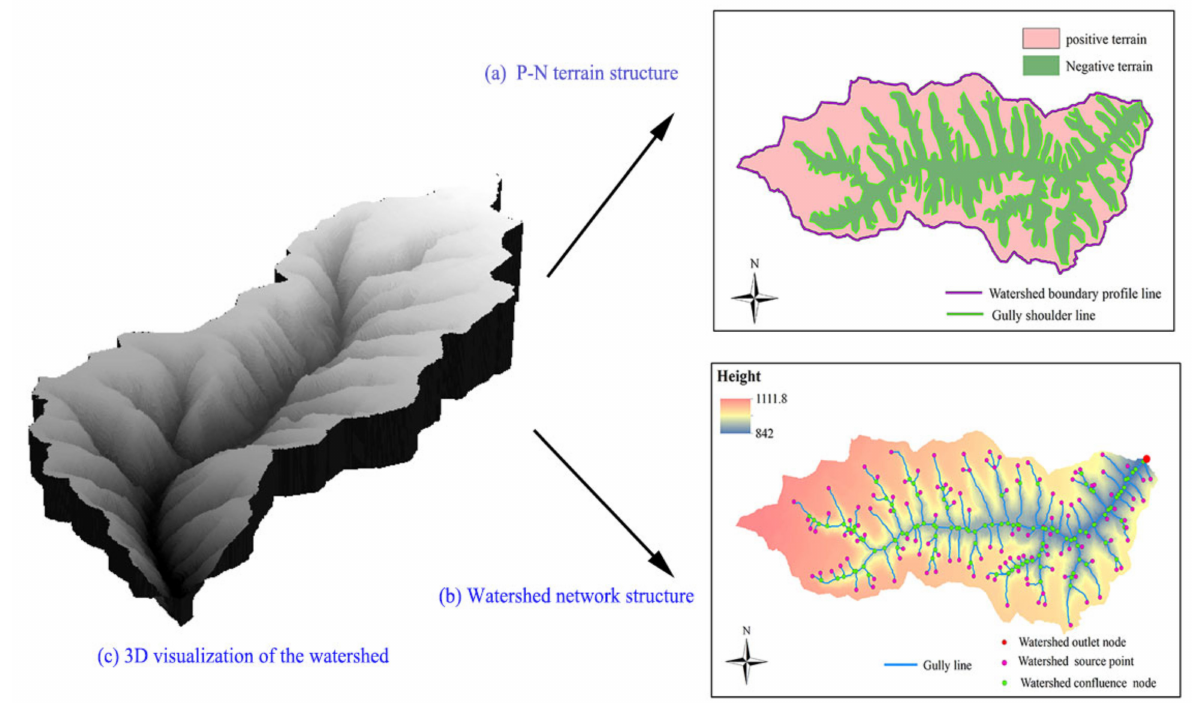
Figure 2. Two kinds of spatial structures for the watershed. ( a ) is the P–N terrain structure. The watershed spatial structure can be divided by the watershed boundary profile line and gully shoulder line into positive terrain and negative terrain. On the other hand, the watershed is a complete gully spatial structure, as shown in ( b ). From the perspective of the complex network, the watershed can be also abstracted as a watershed network structure composed of different types of gully feature nodes linked by gullies ( c